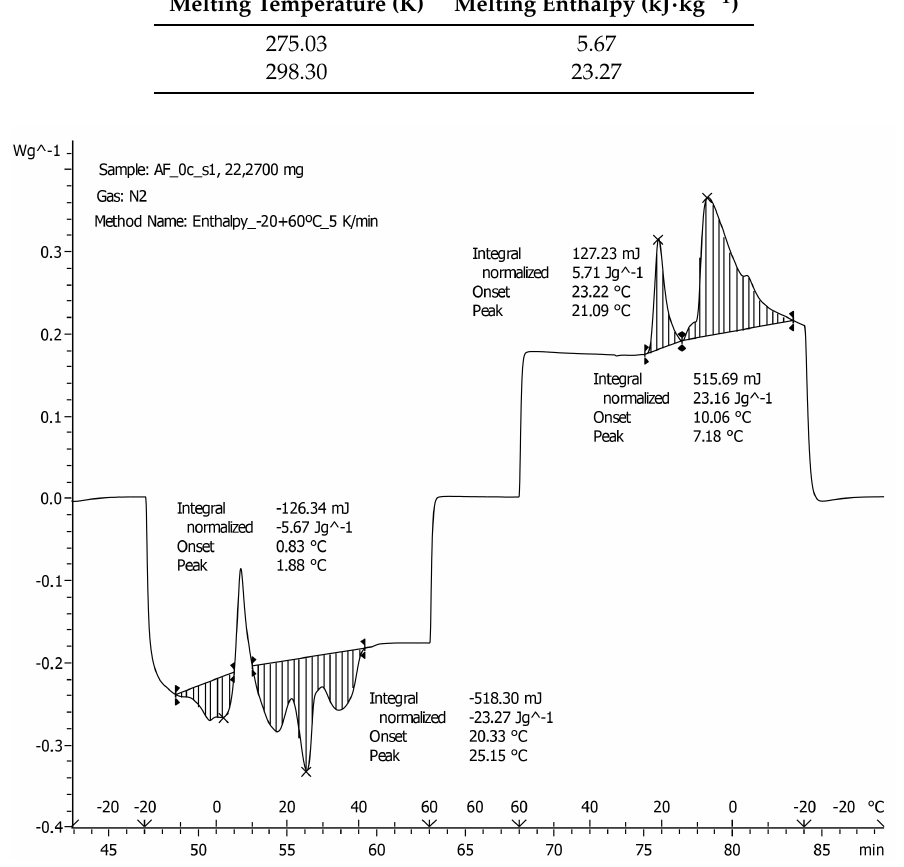
Figure 6. Animal fat differential scanning calorimetry (DSC)